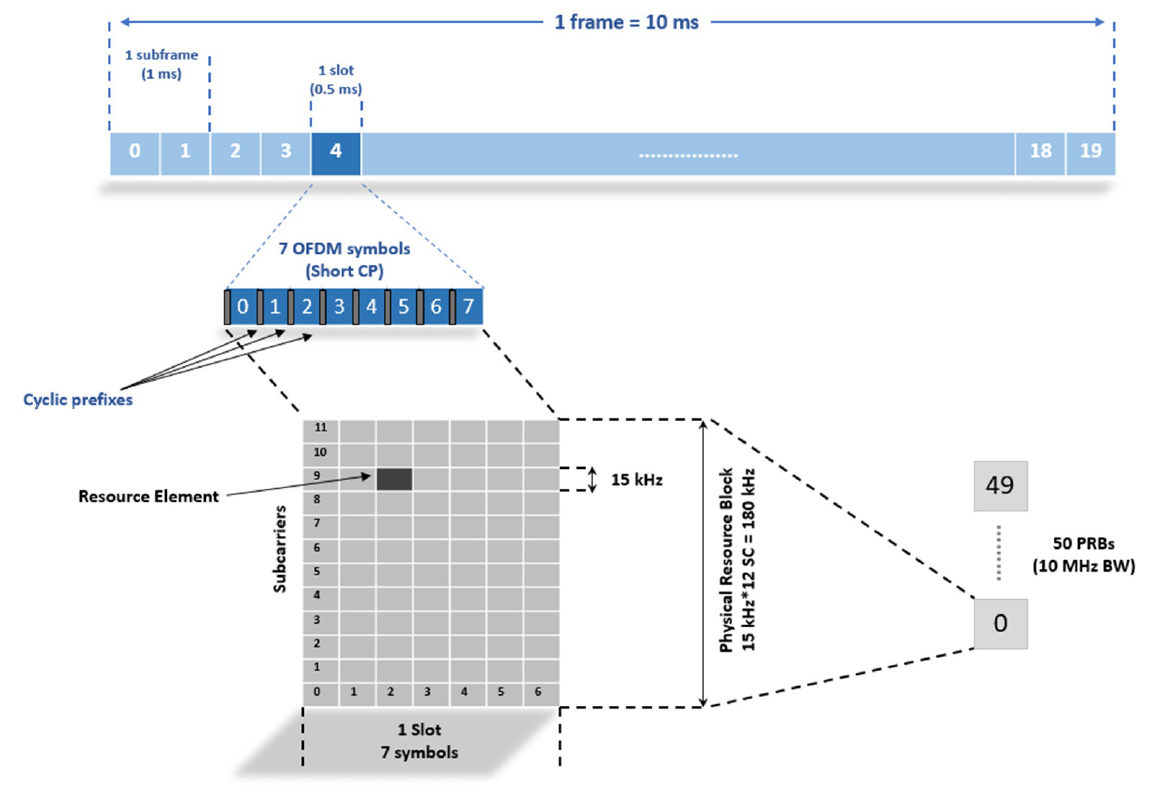
Figure 2. LTE frame.